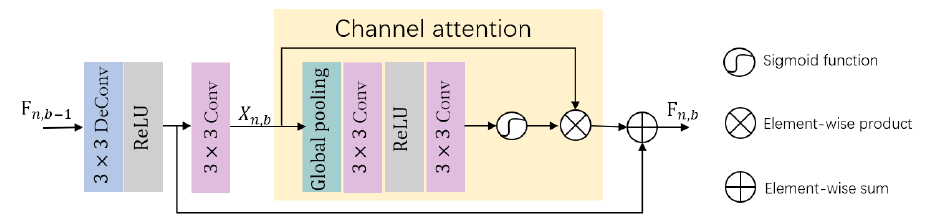
Figure 3. The architecture of RCAU